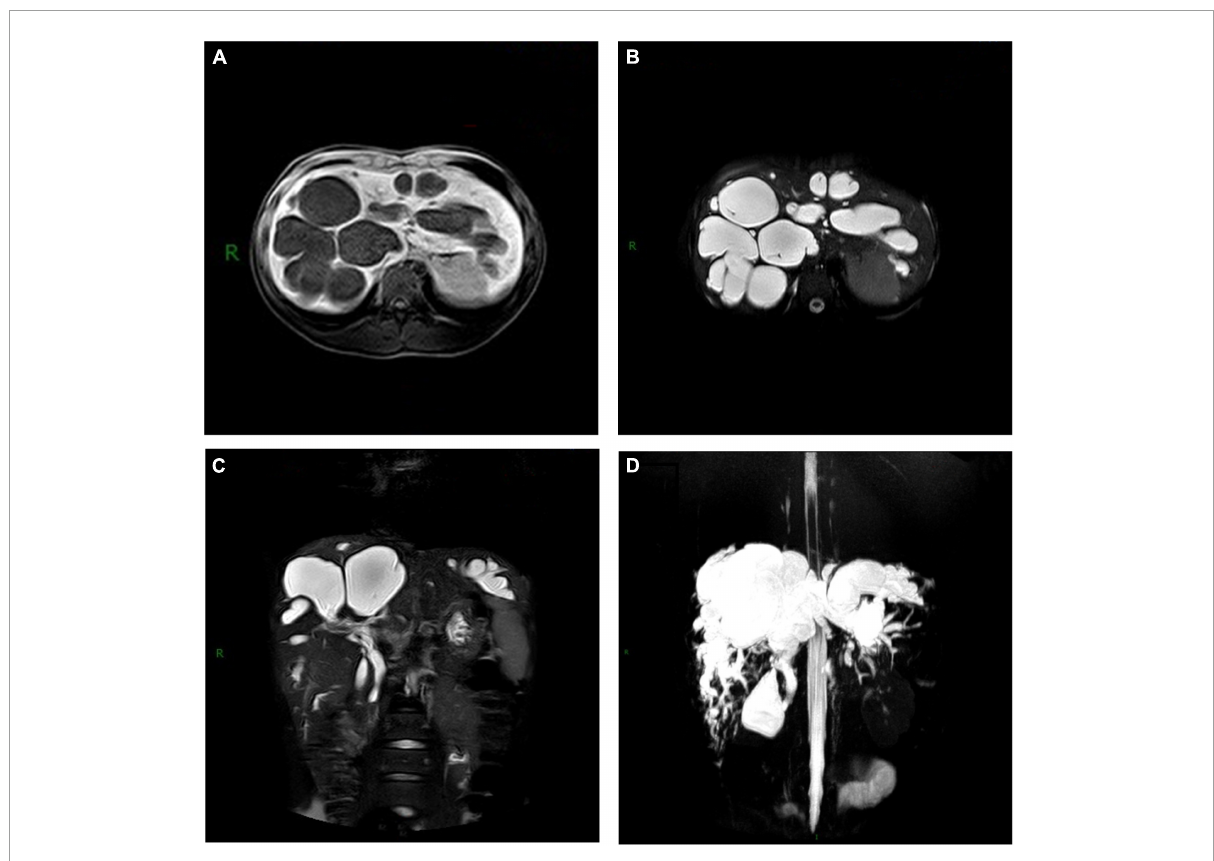
FIGURE3 Magnetic resonance cholangiopancreatography (MRCP) of Caroli’s disease showed multiple cystic lesions of (A) low intensity on T1-weighted images, (B) high intensity on T2-weighted images and (C,D) connected with the biliary